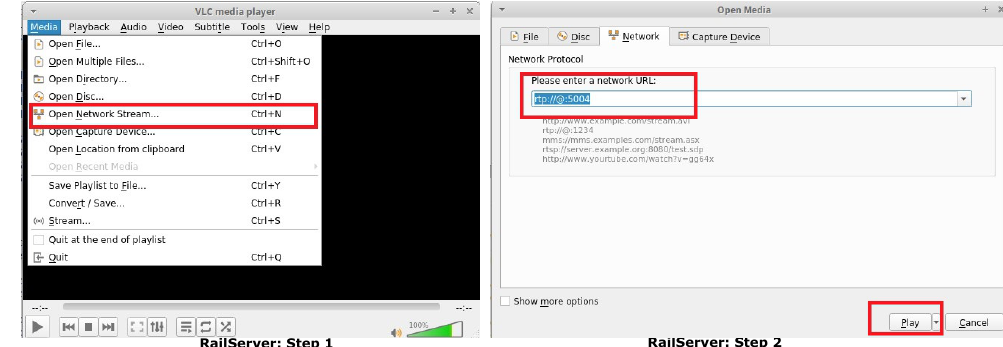
Figure 37. Train1: stream the video.